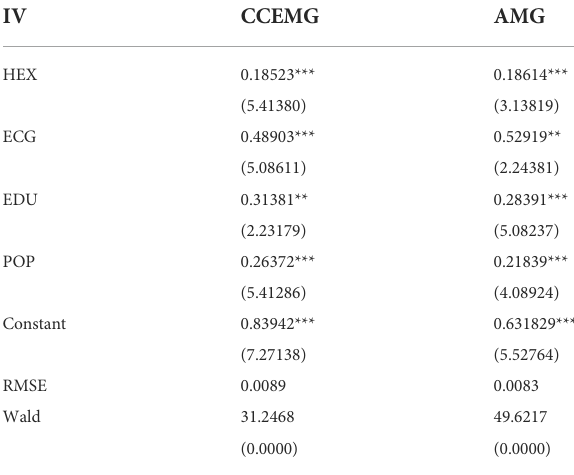
TABLE 7 AMG and CCEMG